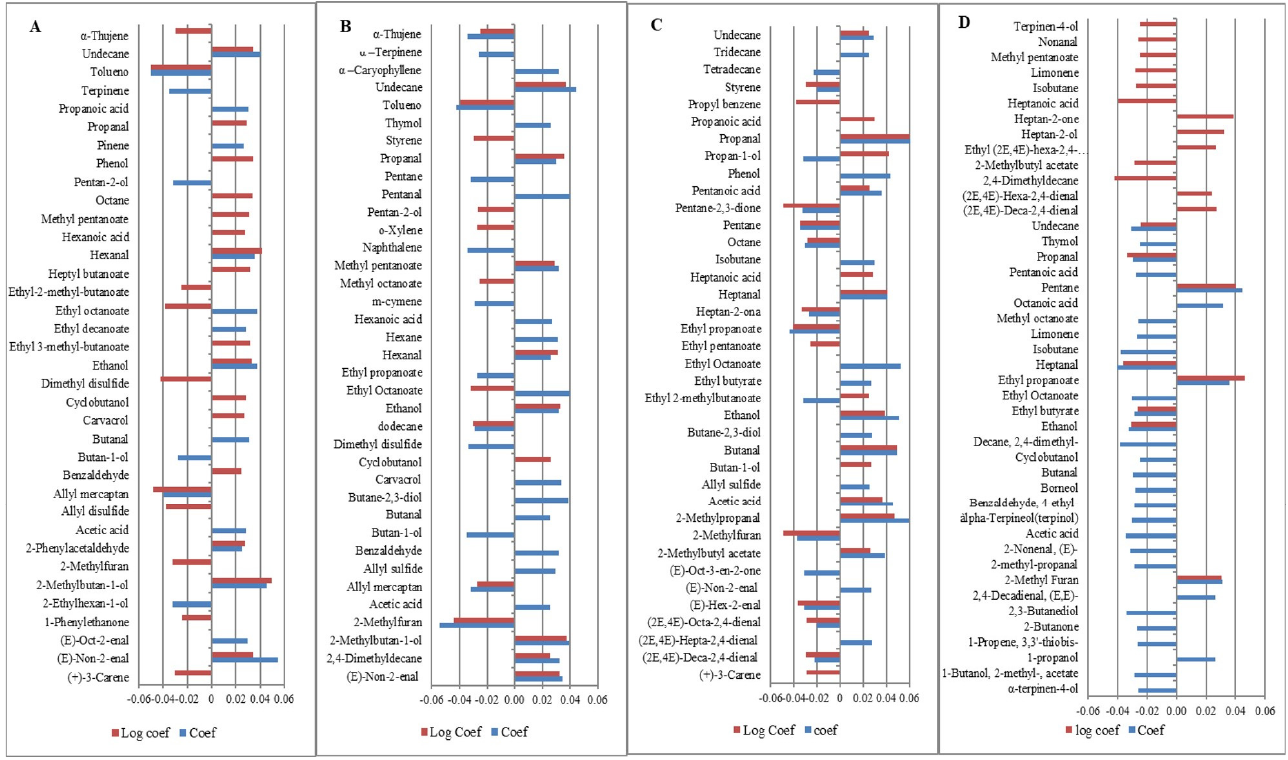
Figure 3. Standardized coefficients of volatile compounds used to predict odors: rancid ( A ), fer- mented ( B ), vinegar ( C ), and pork meat ( D ).